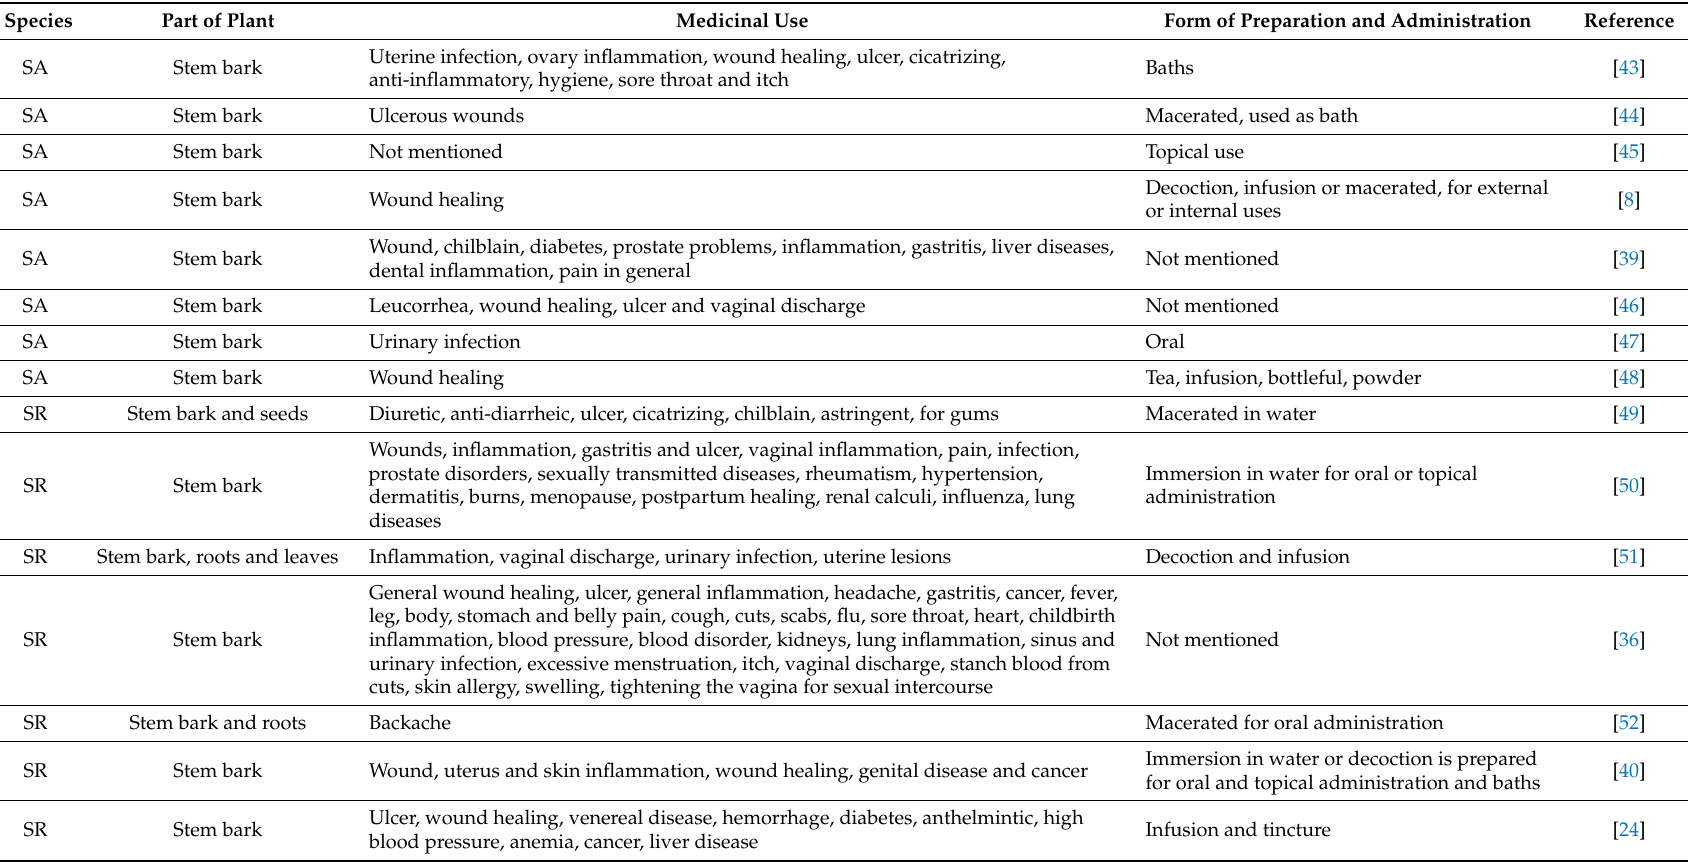
Table 1. Overview of ethnopharmacological reports in literature about “barbatim ã o”